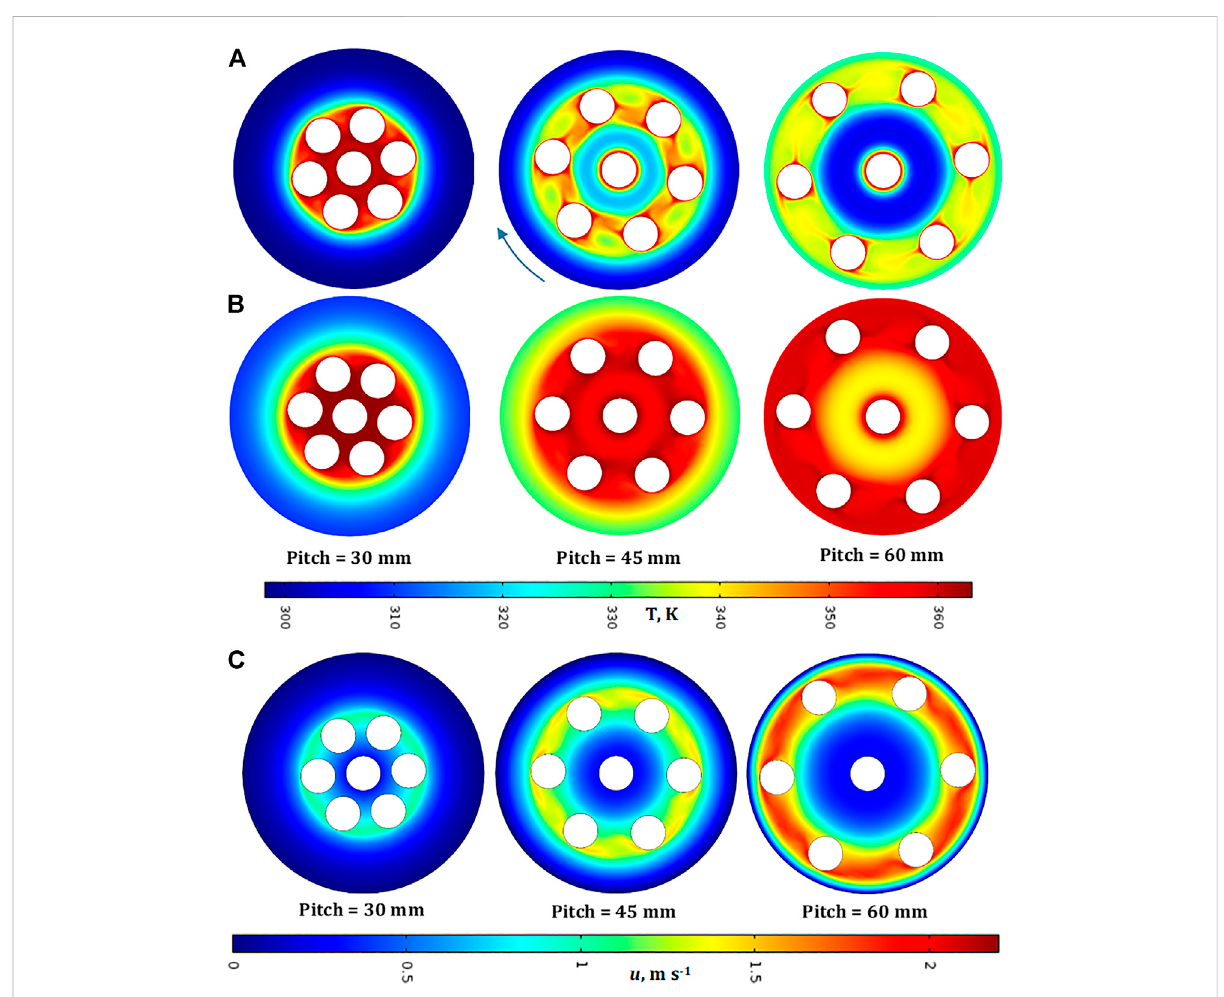
FIGURE 11 Temperature pro fi les at (A) 1 s and (B) 5 s and (C) velocity pro fi le inadiabatic conditions in uniform con fi guration. Fluid: argon, T spot = 90 ° C, T ext = 25 °